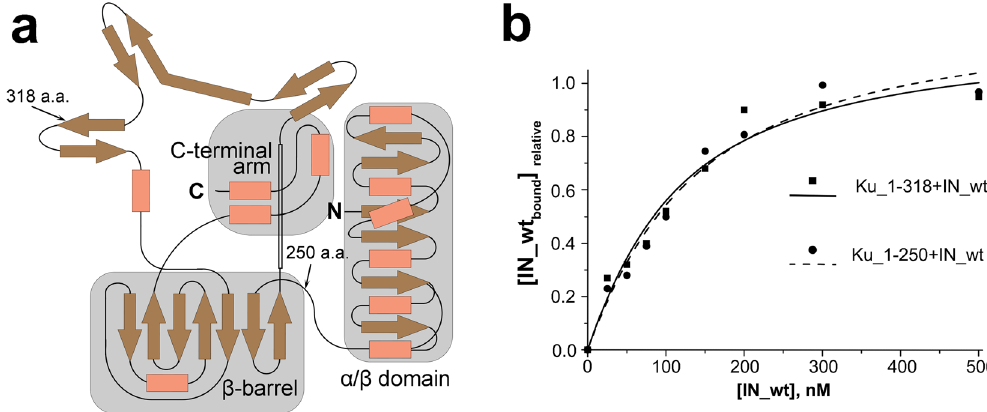
Figure 2. Design of deletion mutants of Ku70 and analysis of their IN-binding capacity. ( a ) Topology map of the secondary structure of Ku70 [35], C-termini of deletion mutants are marked by arrows. ( b ) GST-pull down assay analysis of the binding of Ku70_1-318 ( ■ , solid line) and Ku70_1-250 ( ● , dashed line) with increasing concentrations of IN. Concentration of the Ku truncated mutants was 50